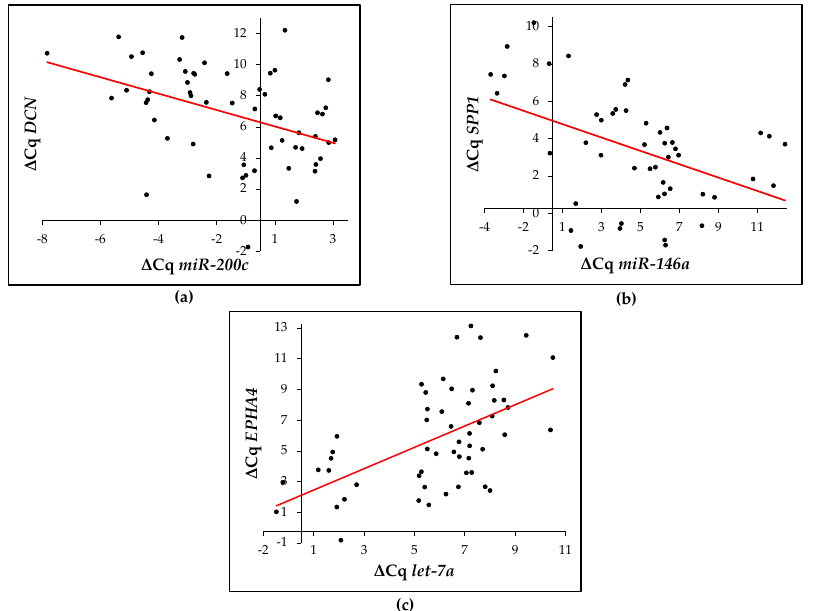
Figure 5. Representative figure of Spearman correlation coefficient for ( a ) DCN , ( b ) SPP1 and ( c ) EPHA4 .